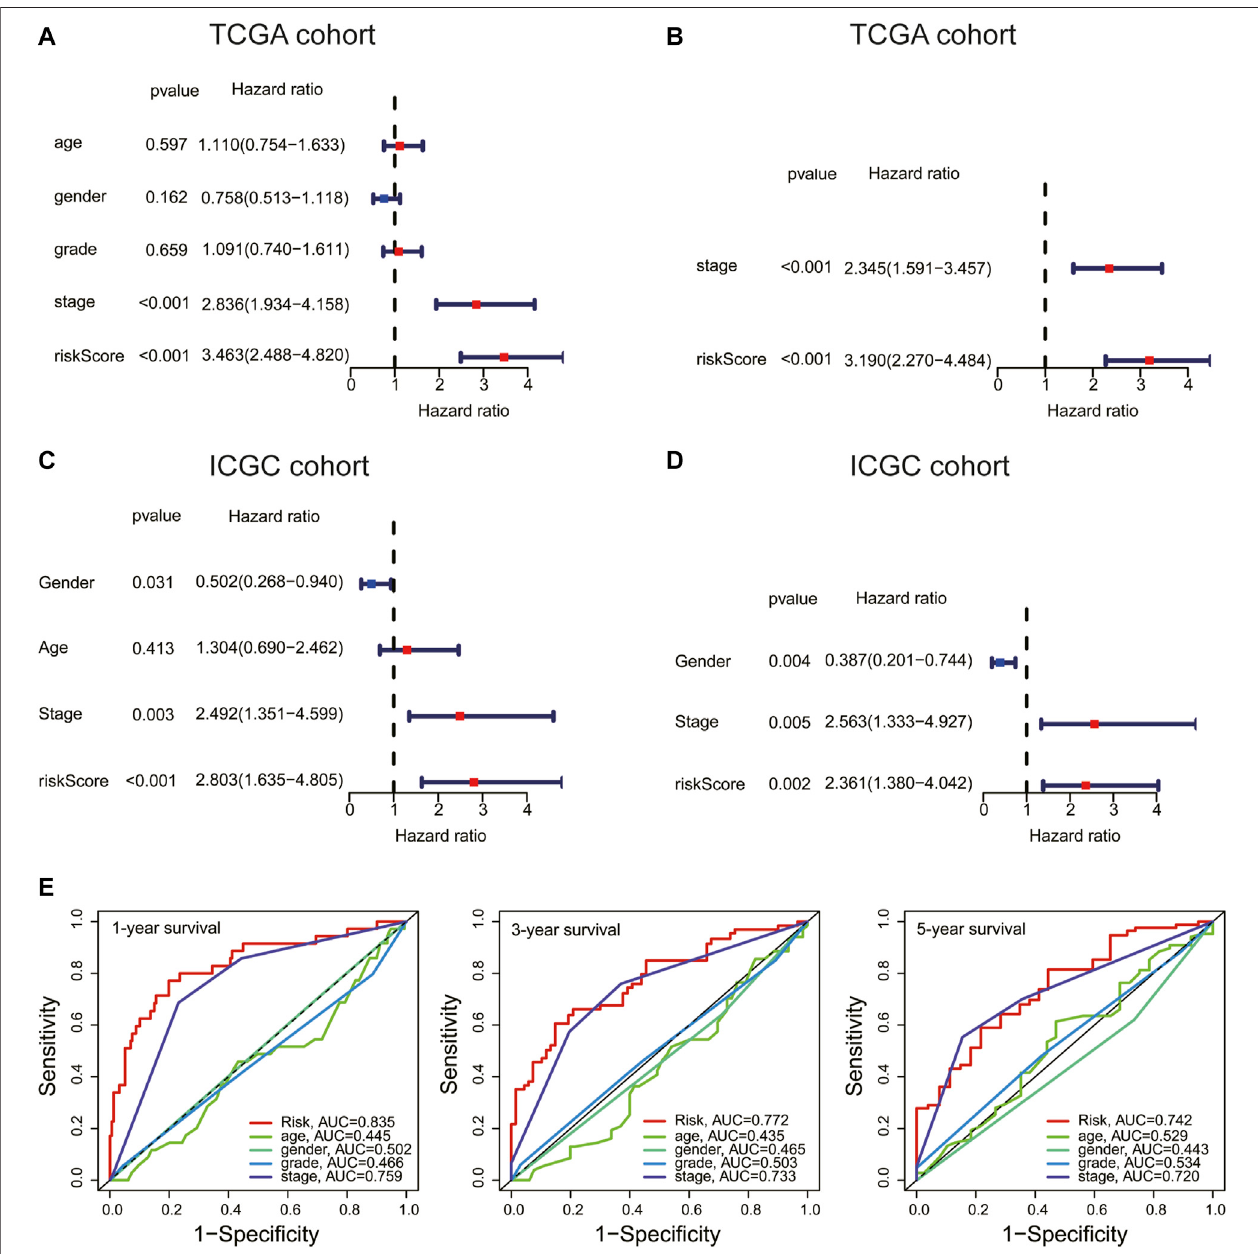
FIGURE 5 | Risk score is an independent prognostic factor for HCC. (A,C) Univariate and (B,D) multivariate Cox analyses of the risk score and clinical variables in the TCGA and International Cancer Genome Consortium (ICGC) cohort. (E) ROC curve analysis of the risk score and clinicopathological characteristics in predicting 1-, 3-, and 5-year survival